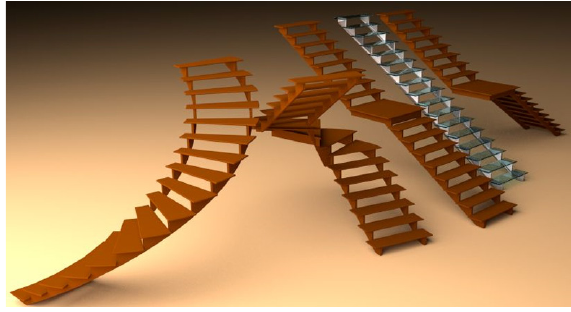
Fig. 1. Different forms of stairs (stairways and